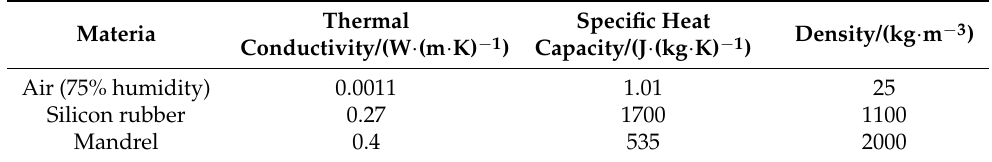
Table 2. Thermal parameters of simulation model.